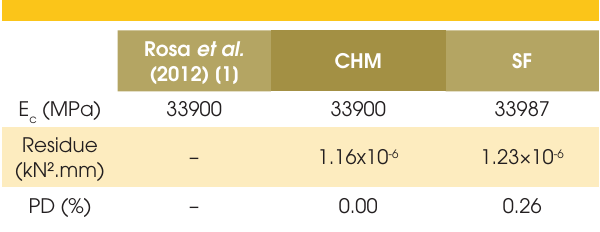
Table 1 – Elasticity modulus results obtained by the program